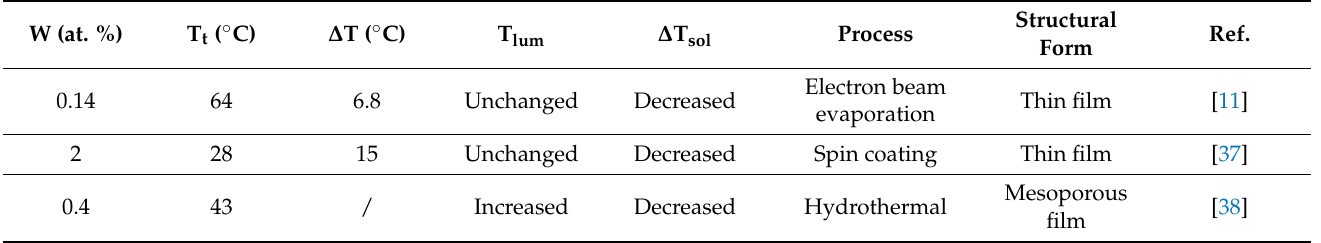
Table 2. Comparison of some of the W-doped VO 2 reported works on thermochromic parameters including T t , ∆ T, T lum , and ∆ T sol , with those of our present study. The terms « unchanged, increased, decreased » correspond to changes in the T lum and ∆ T sol values of W-doped VO 2 compared to those of undoped VO 2 .